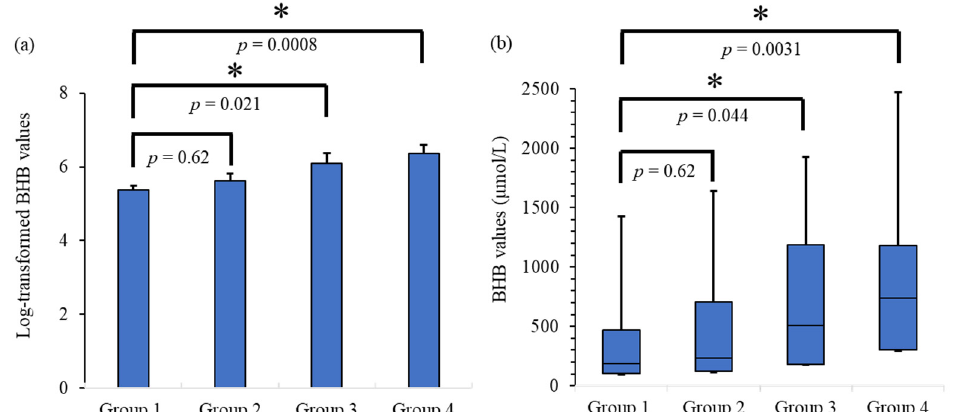
Figure 1. ( a ) Bar graph of the log-transformed BHB values with an error bar as the result of Dunnett’s test. The error bar depicts the standard error. ( b ) Boxplot graph of the BHB values as the result of the Steel’s test. Both tests showed the tendency that longer PMI groups result in higher BHB values. The significant differences between Group 1 and Group 3, as well as Group 1 and Group 4, were confirmed by both tests. * means statistical significance ( p < 0.05). BHB, β -hydroxybutyrate.